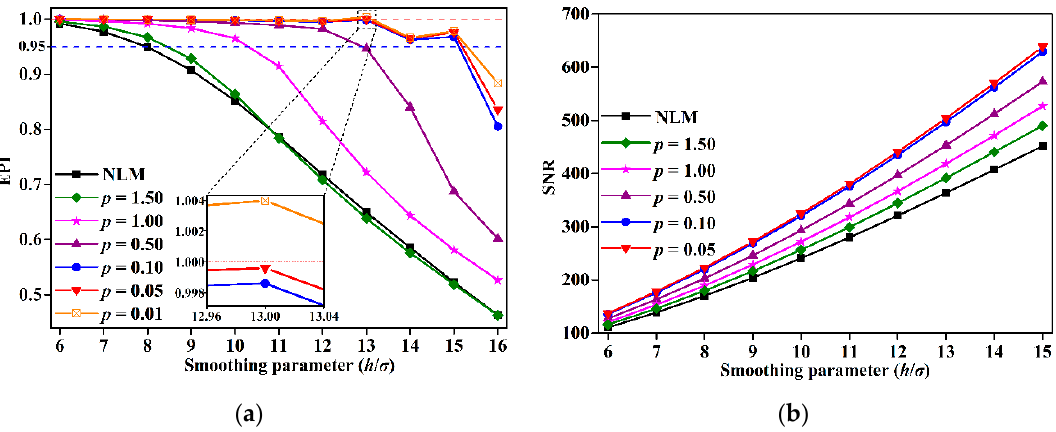
Figure 4. Comparison of evaluation results with variable h and p : ( a ) the change of EPI with h at different p . Insert: the apparent EPI value error when p = 0.01 and h = 13 σ ; ( b ) the change of SNR with h at different p